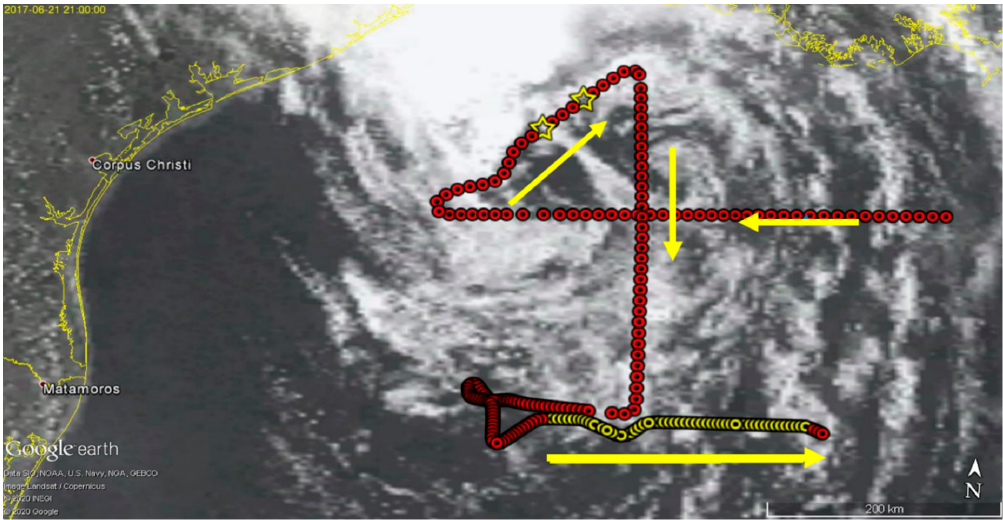
Figure 18. DC-8 and DAWN flight track investigating TS Cindy on 21 June 2017 with GOES13 VIS imagery at 2100Z along with the location of the selected profiles (gold star) to the NW and the series of profiles (yellow line) to the south of the center (Google Earth).